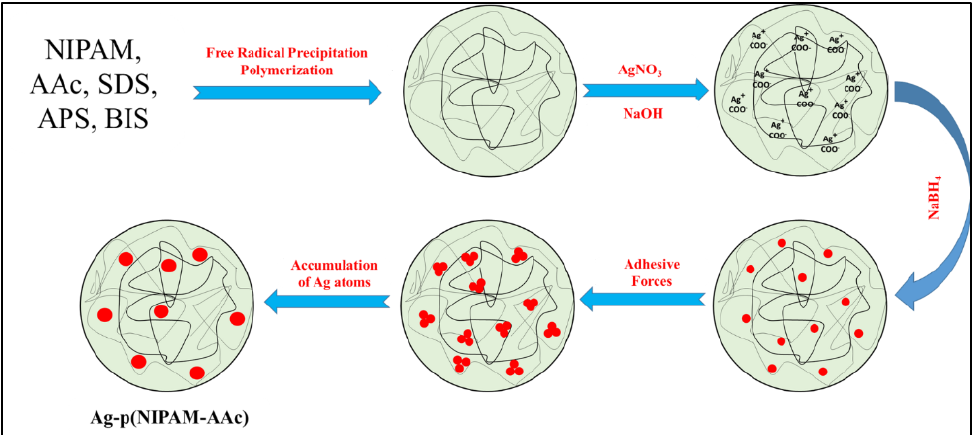
Figure 9. Diagrammatic representation of the synthesis of Ag nanoparticles within p(NIPAM-AAc) HMGs through in situ reaction.